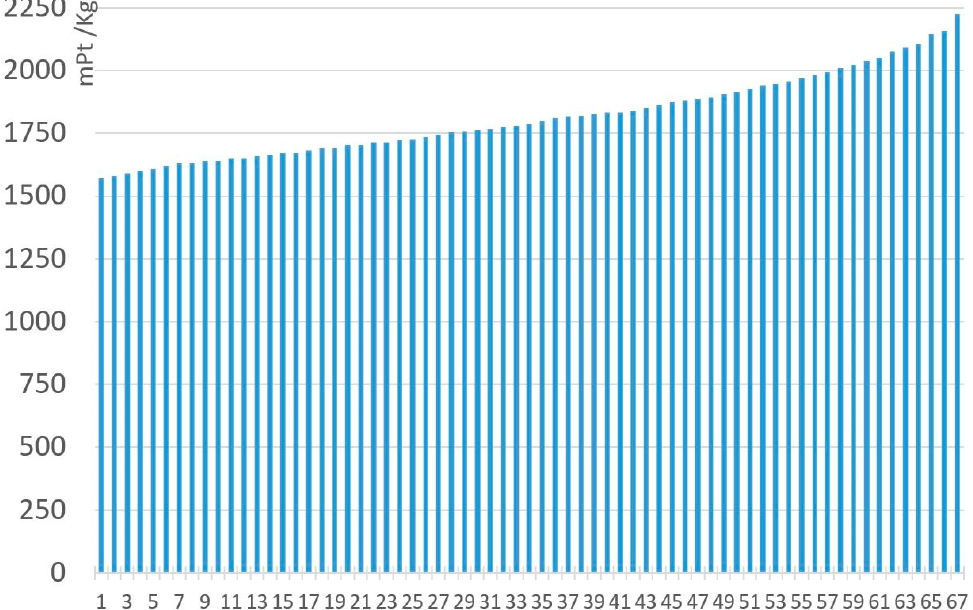
Figure 7. Environmental impact (RMA + Production). of 1 kg MnZn for the 67 ferrites, under the ReCiPe methodology.